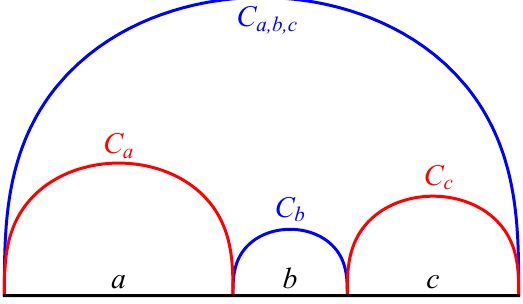
Figure 7 . The demonstration of mutual